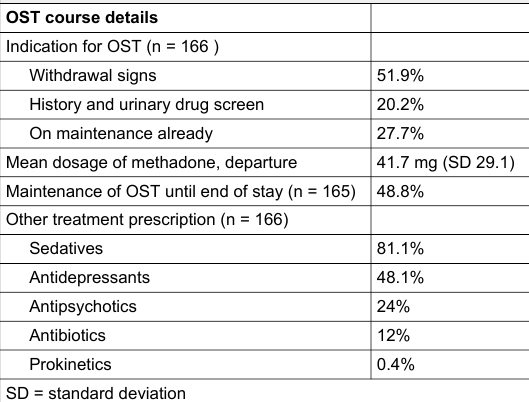
Table 3: Information about course for opioid substitution treatment (OST)